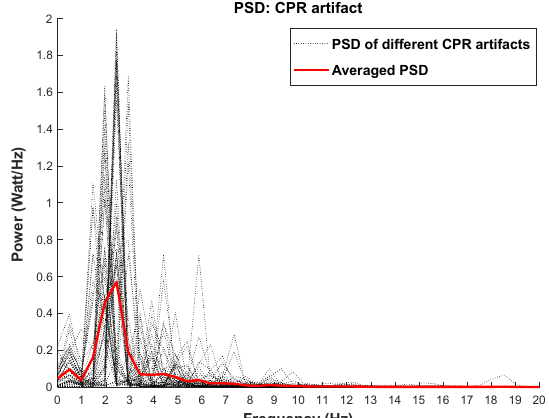
Figure 1. PSD of different CPR artifacts and the averaged PSD are shown in black dashed lines and red line, respectively.